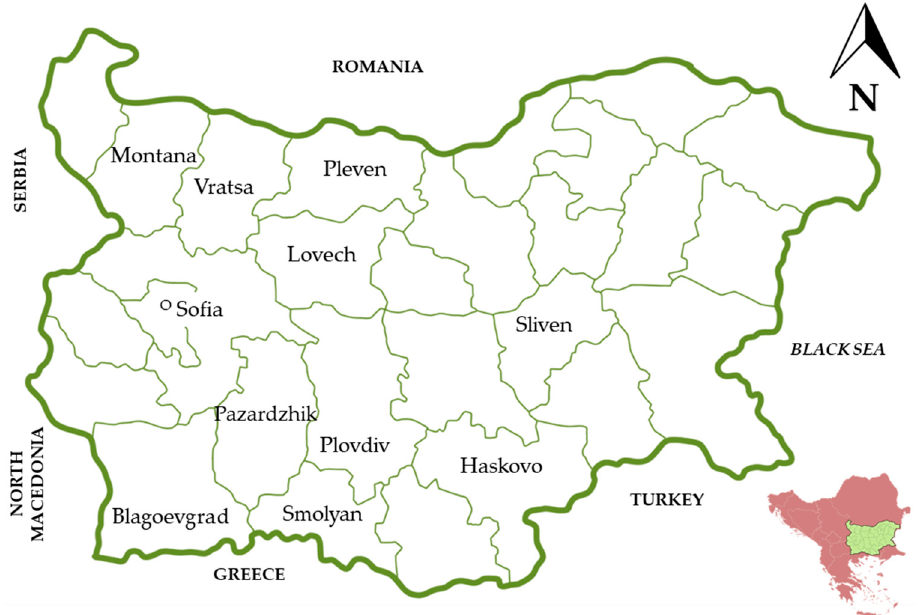
Figure 1. Map of the studied provinces (location of Bulgaria in the Balkan Peninsula on the bottom right).